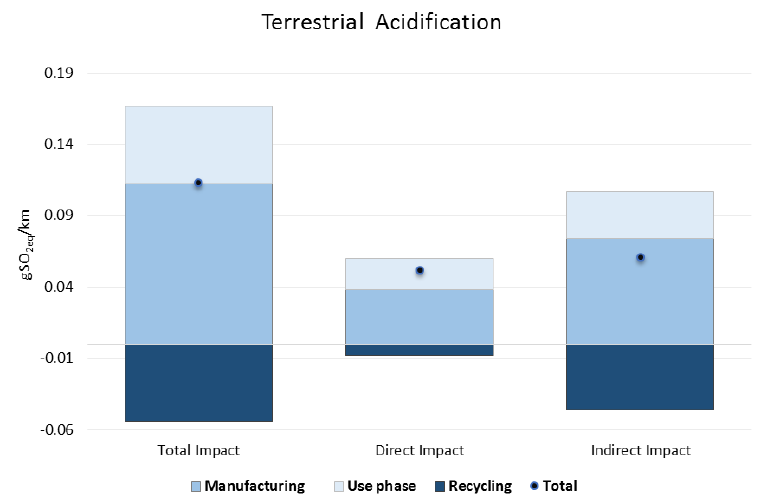
Figure 4. Terrestrial Acidification impact per km.